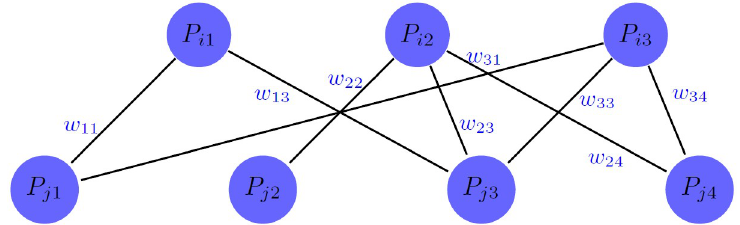
Fig 3. Schematic representation of the bipartite graph between the set of target proteins for a drug pair.